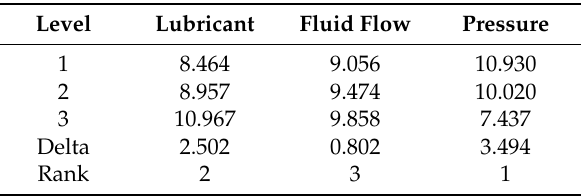
Table 5. Mean of S / N response for surface